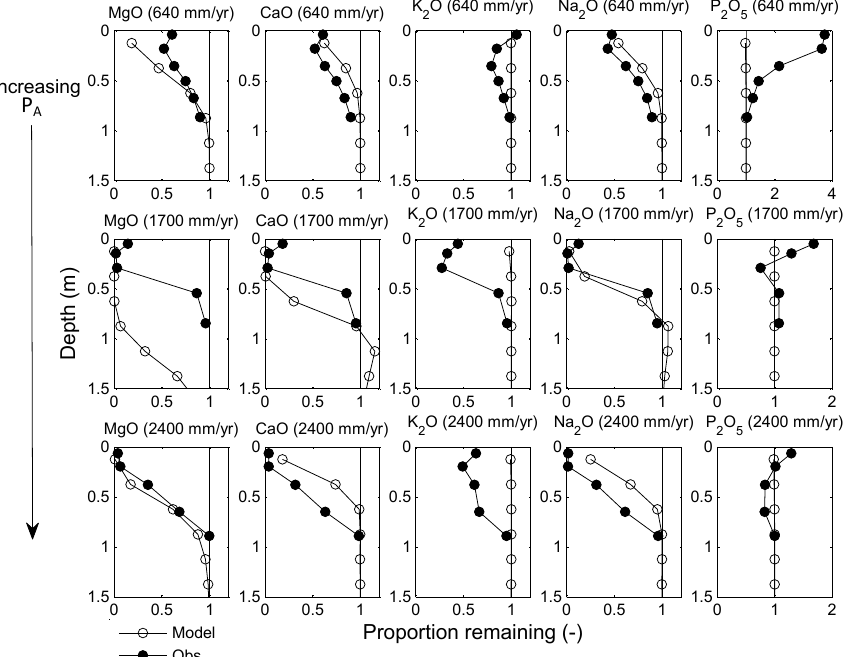
Figure 7. Observed vs. simulated oxide losses/gains across a mean annual precipitation gradient ( P A ) on the 10ka Kona lava flow. Values < 1 indicate a loss relative to the parent material, and values > 1 indicate relative accumulation.